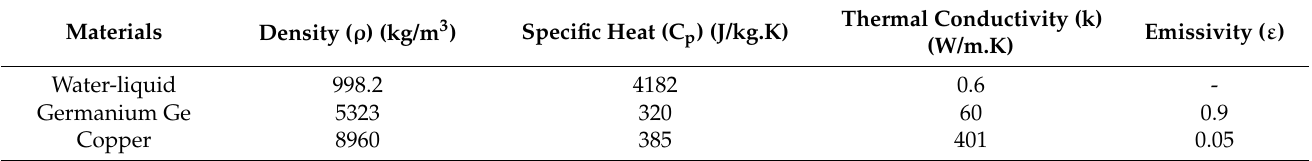
Table 1. Materials properties for the CPVT